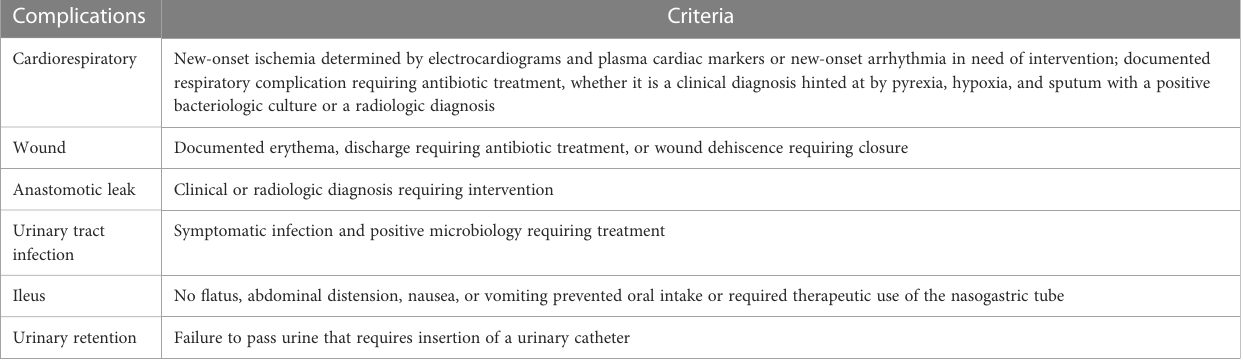
TABLE 1 De fi nition of perioperative